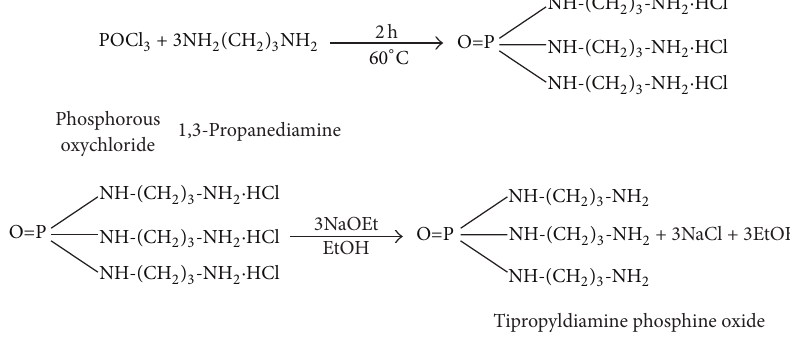
Scheme 2: Synthesis of tripropyldiamine phosphine oxide.